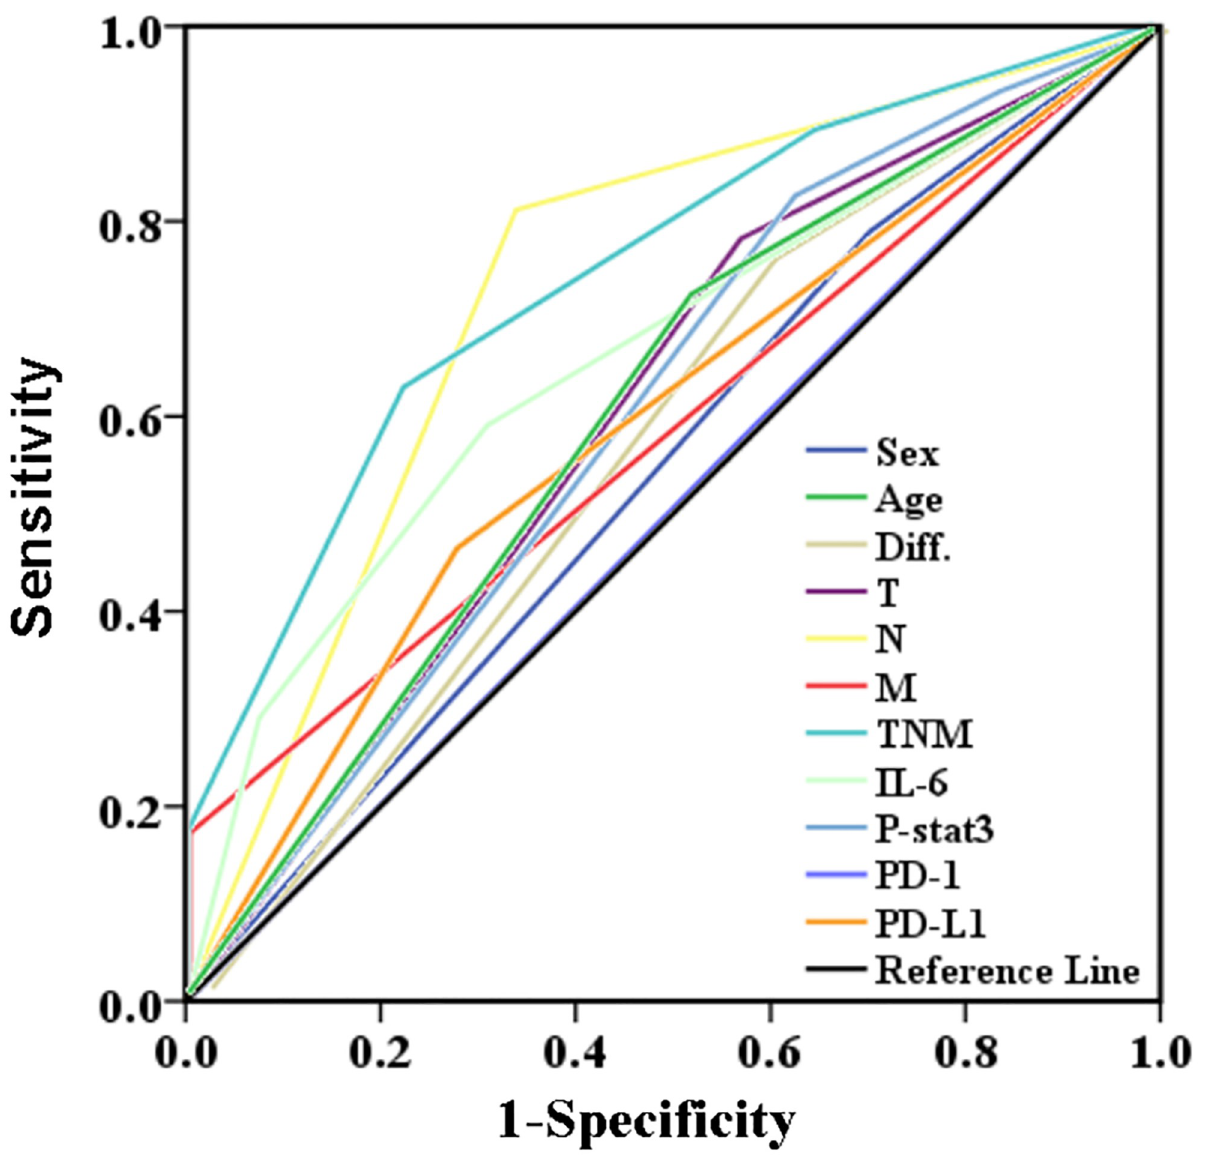
Fig 3. ROC curve of clinicopathological index and immunohistochemical index to predict survival of gastric patients. ROC curves reveal performance abilities of clinicopathological indices and IHC bio-indicators affecting patients’ survival. As shown, the diagonal black line is the reference